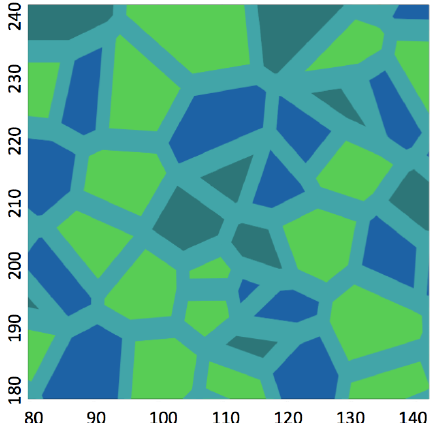
Fig. 2. Poisson–Voronoi diagrams: different colors represent dif- ferent types of surfaces: light green if the polygon center is moist (water table > 10cm below the surface), dark green if it is saturated (water table < 10cm below as well as < 10cm above the surface) and blue if it is wet (water table > 10cm above the surface and the polygon is covered by open water). Dimensions of polygon edges in the figure are not to scale, since in our model they cover up to 70% of the whole polygon area. Distances on x and y axes are in meters.